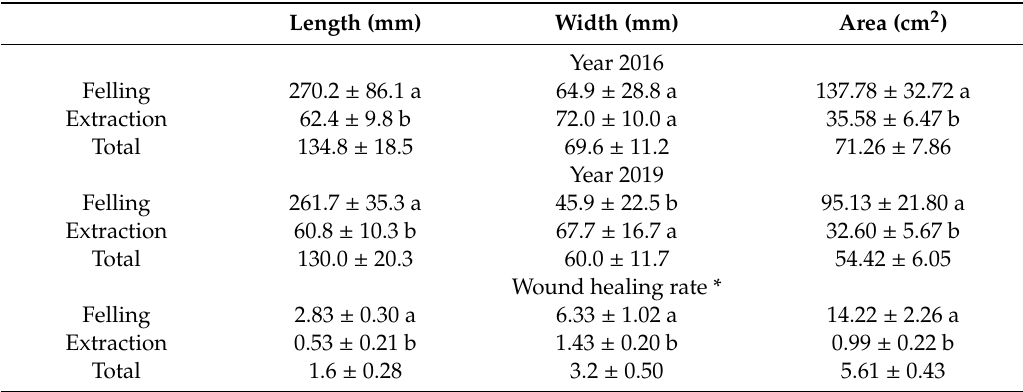
Table 4. Dimensions and healing rates of wounds per origin (felling, extraction and total wounds) in the first (2016) and second (2019)